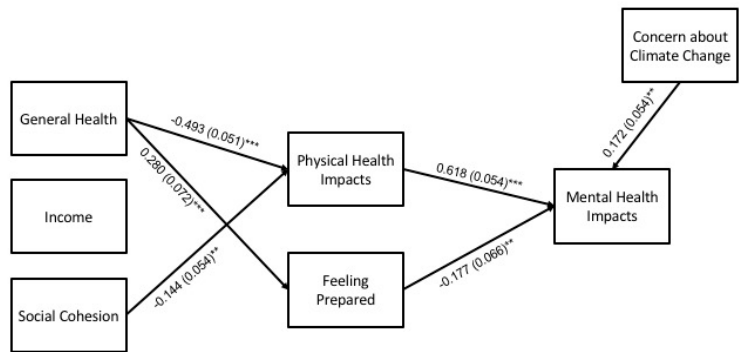
Figure 2. Path model for mental health impacts during summer heat (N = 426). Statistically significant pathways are shown with standardized estimates and standard errors (SEs) in parentheses. Statistical significance levels are: ** p < 0.01, and *** p < 0.001. Table 5. Path analysis results for summer heat, overall (N = 426).